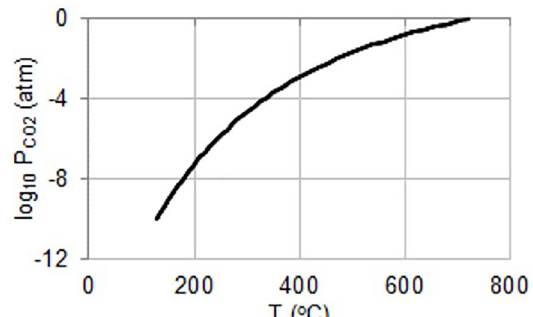
Figure 3. Equilibrium partial pressure of CO temperature for Li